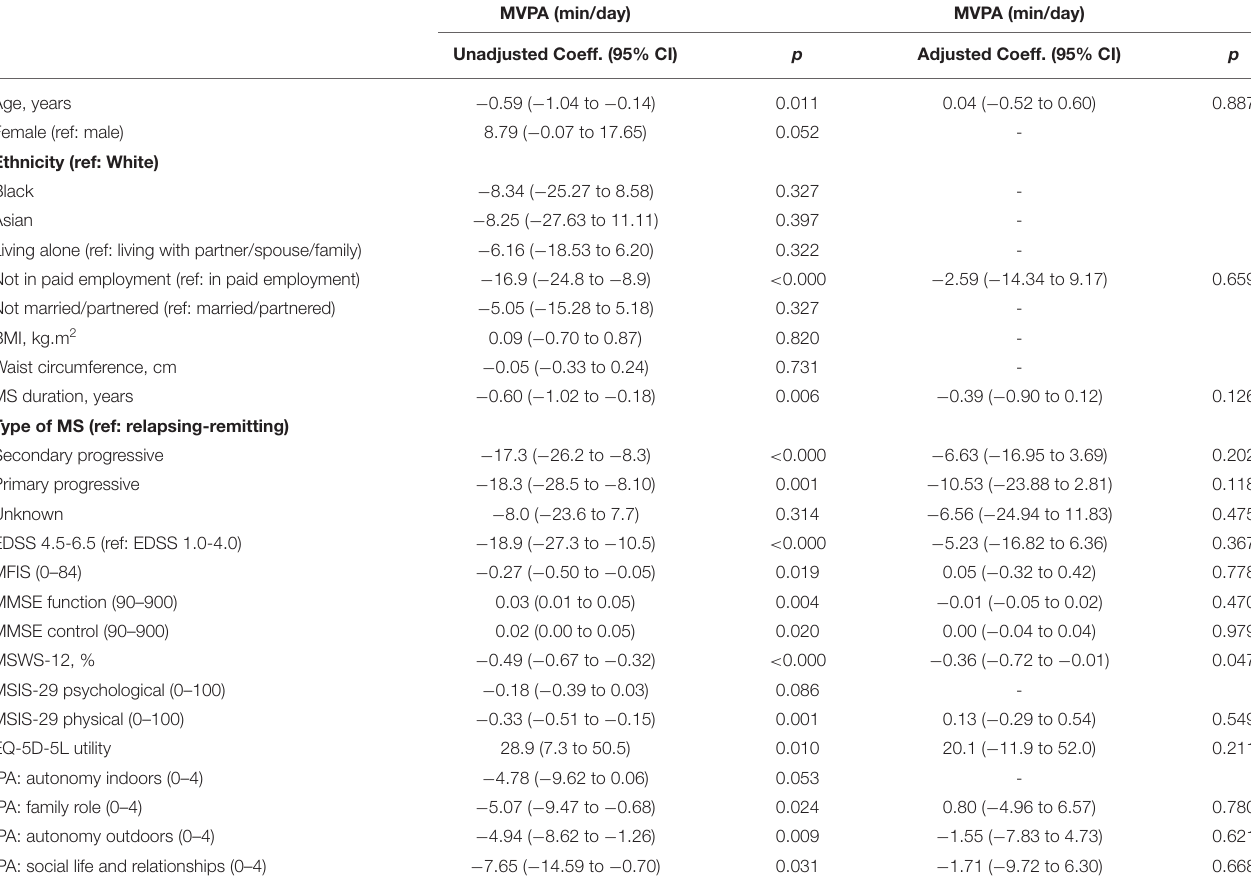
TABLE 4 | Associations between demographic, clinical characteristics, and moderate-to-vigorous physical activity. MVPA (min/day) MVPA (min/day)